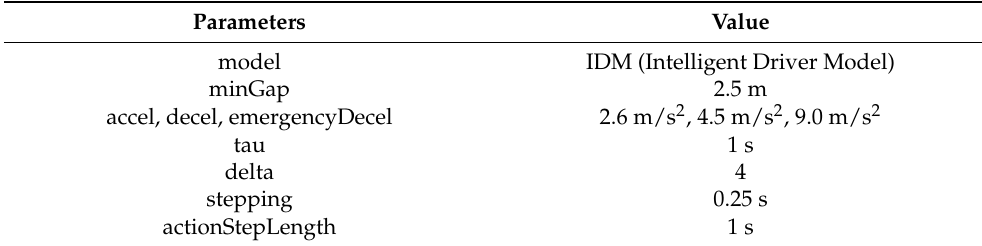
Table 4. Car-following model parameters (human-driven model).